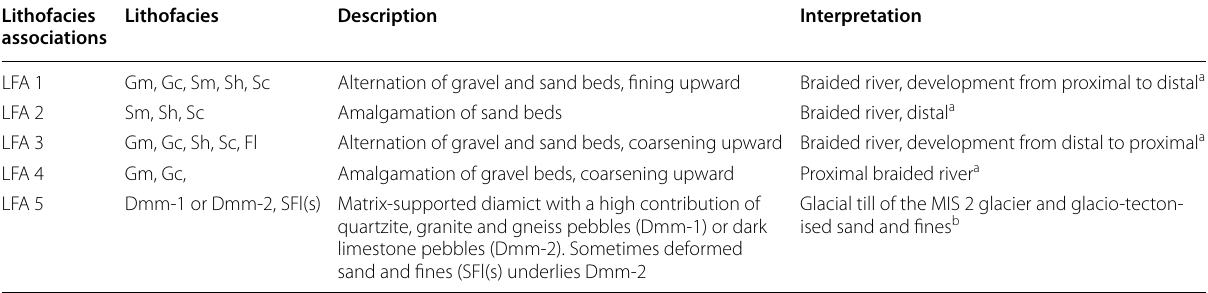
Table 2 Summary of the lithofacies associations. Interpretation of depositional environment is based on Miall (1978) and Buechi et